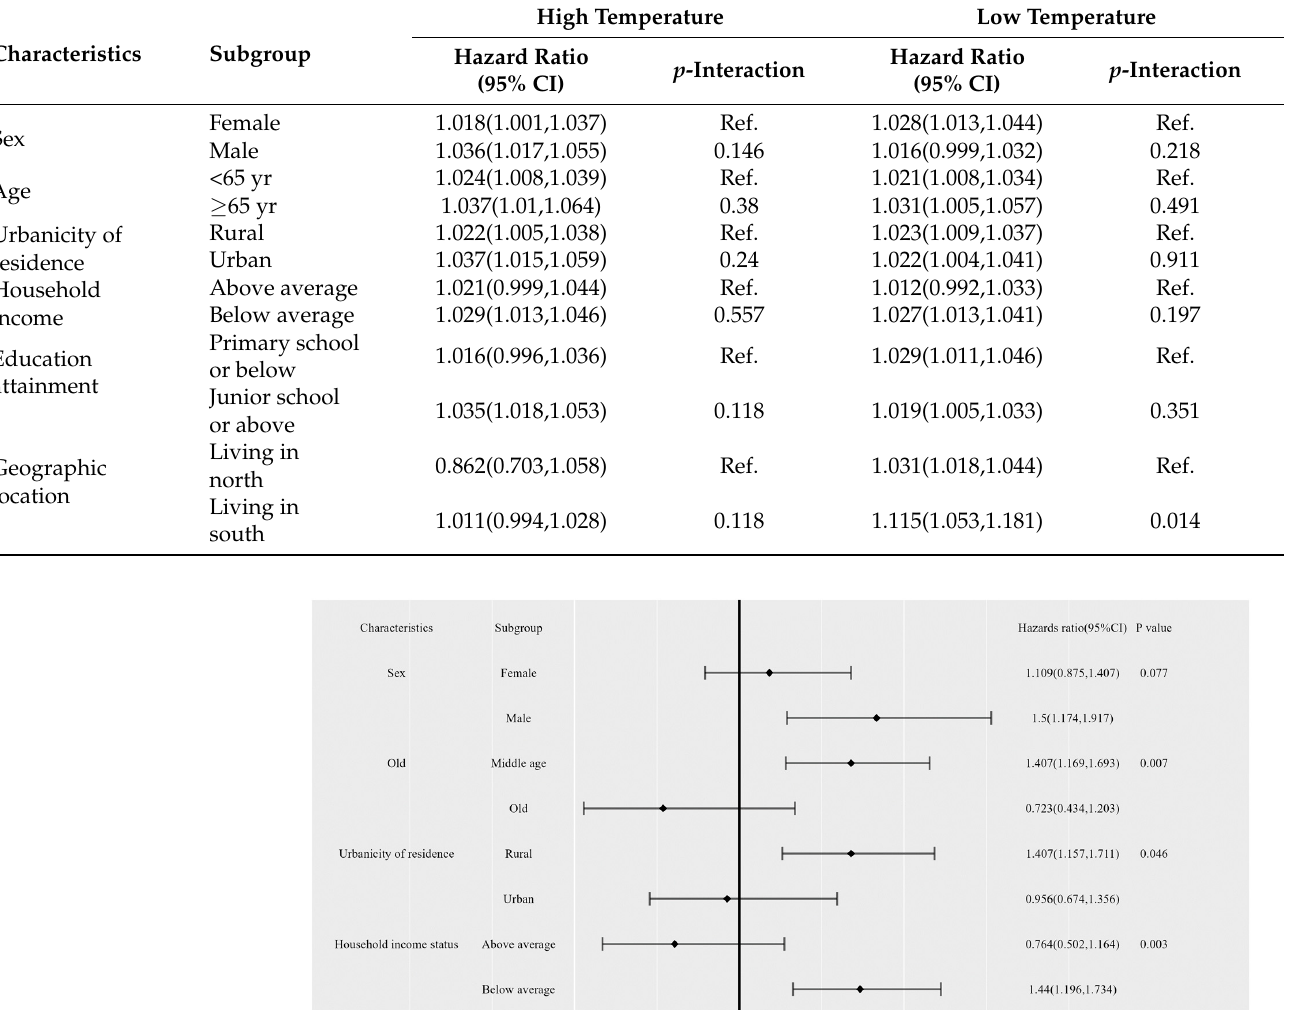
Table 3. Hazards ratios of depressive symptoms, each unit increase in low temperature and annual change in cool nights by baseline characteristics.